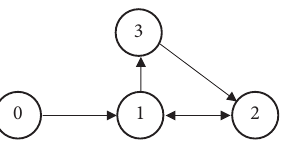
Figure 2: The communication topology of the systems. The root node 0 denotes the virtual